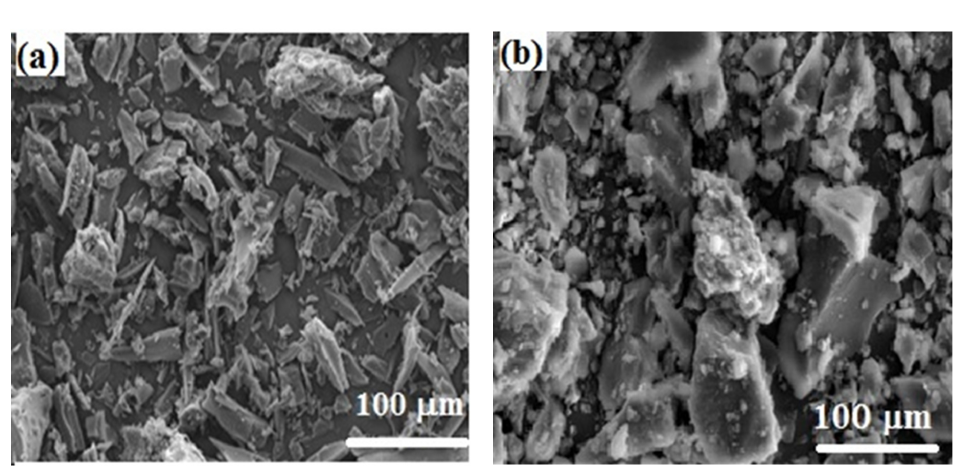
Figure 3. SEM images of non-coking coal samples: ( a ) charcoal and ( b ) coal. Charcoal and coal samples were heated up to 1100 °C in the CO 2 atmosphere to follow up its gasification rates using the TG technique. The TG and derivative thermogravimetric (DTG) curves for coal and charcoal are shown in Figure 4. It is clear that both carbon-bearing materials have exhibited three weight loss steps, as given in Table 3. The liberation of coal volatiles was started at about 300 °C and ended at 550 °C with a marked peak in the DTG curve, which ensures the complete removal of all volatiles. While in the case of charcoal, the de-volatilization started at 550 °C and stopped at 700 °C with a small peak in DTG. The gasification of coal and charcoal nearly starts at the same temperature, 800 °C. Furthermore, charcoal gives a stronger peak in DTG than coal. This behavior could be attributed to the higher surface area and fixed carbon.